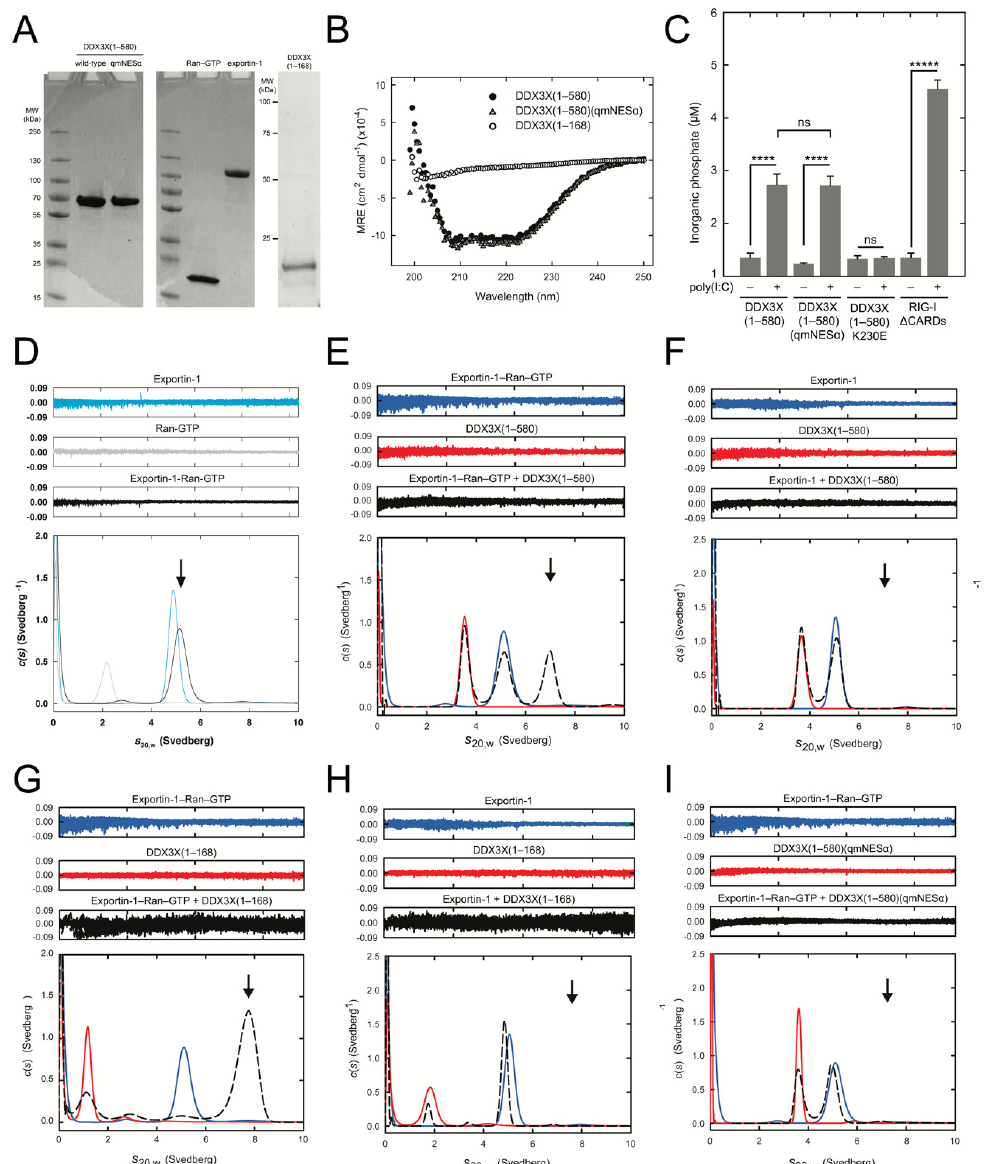
Figure 3. A nuclear export signal (NES) within the DDX3X N-terminal region is necessary and sufficient for direct binding to exportin-1 in a Ran-GTP-dependent manner. ( A ) Coomassie-stained SDS-PAGE of recombinant DDX3X(1–580), DDX3X(1–580)(qmNES α ), Ran-GTP, exportin-1 and DDX3X(1–168). ( B ) Circular dichroism spectra of DDX3X(1–580) (black circles), DDX3X(1–580)(qmNES α ) (grey triangles), and DDX3X(1–168) (white circles). Ellipticity (mdeg) normalized to mean residue ellipticity (deg cm 2 dmol − 1 ). ( C ) RNA-dependent ATP hydrolysis assay measuring inorganic phosphate production from the ATPase activity of recombinant wild-type DDX3X(1-580) or variants thereof. The ATPase-deficient DDX3X(K230E) mutant was a negative control, while the RIG-I ∆ CARDS protein was a positive control. Results represent the mean ± SD ( n = 3). Student’s t -test with Holm–Sidak multiple comparisons test for significance; *****, p ≤ 0.0001; ****, p ≤ 0.001; ns, not significant. ( D ) Continuous sedimentation coefficient distribution [ c ( s )] plotted as a function of s 20,w for recombinant exportin-1 (light blue line), Ran-GTP (gray line) and the exportin-1-Ran-GTP complex following incubation at equimolar concentrations (black line). ( E – H ) Continuous sedimentation coefficient distribution [ c ( s )] plotted as a function of s 20,w for recombinant DDX3X variants (red line) and exportin-1 with or without Ran-GTP (blue line) alone and following incubation at equimolar concentrations (black dashed